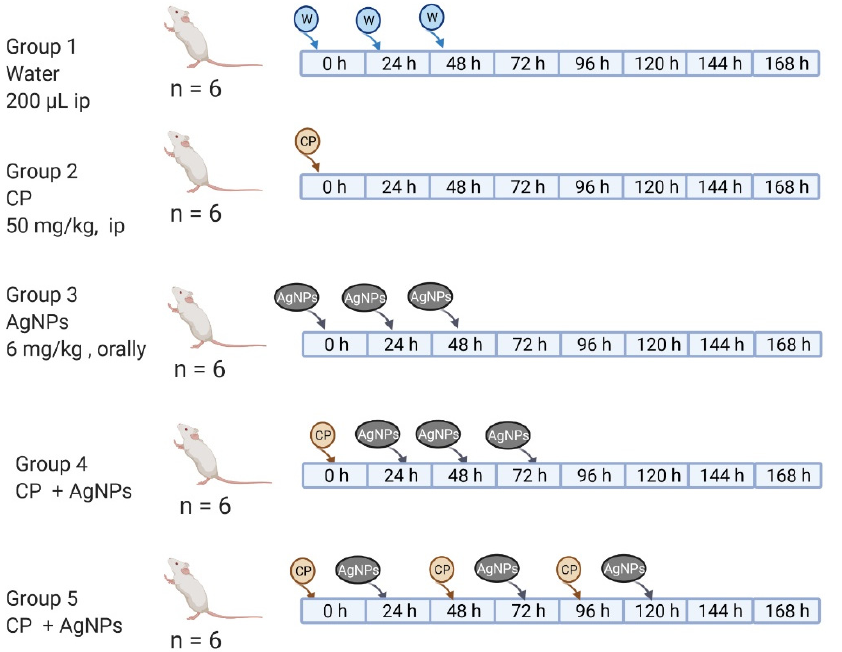
Figure 1. Administration schemes: Group 1: water (0, 24, 48), Group 2: CP (0 h), Group 3: AgNPs (0, 24, 48), Group 4: CP +AgNPs; CP (0 h) + AgNPs (24, 48, 72 h), and Group 5: CP +AgNPs; CP (0, 48, 96 h) + AgNPs (24, 72, 120 h).